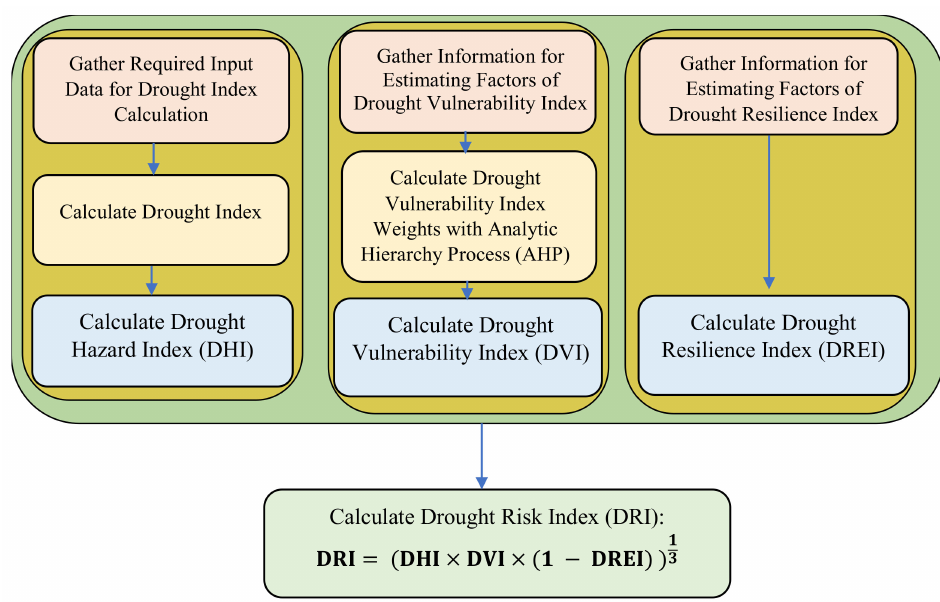
Figure 2. Scheme of the methodology for calculating Drought Risk Index